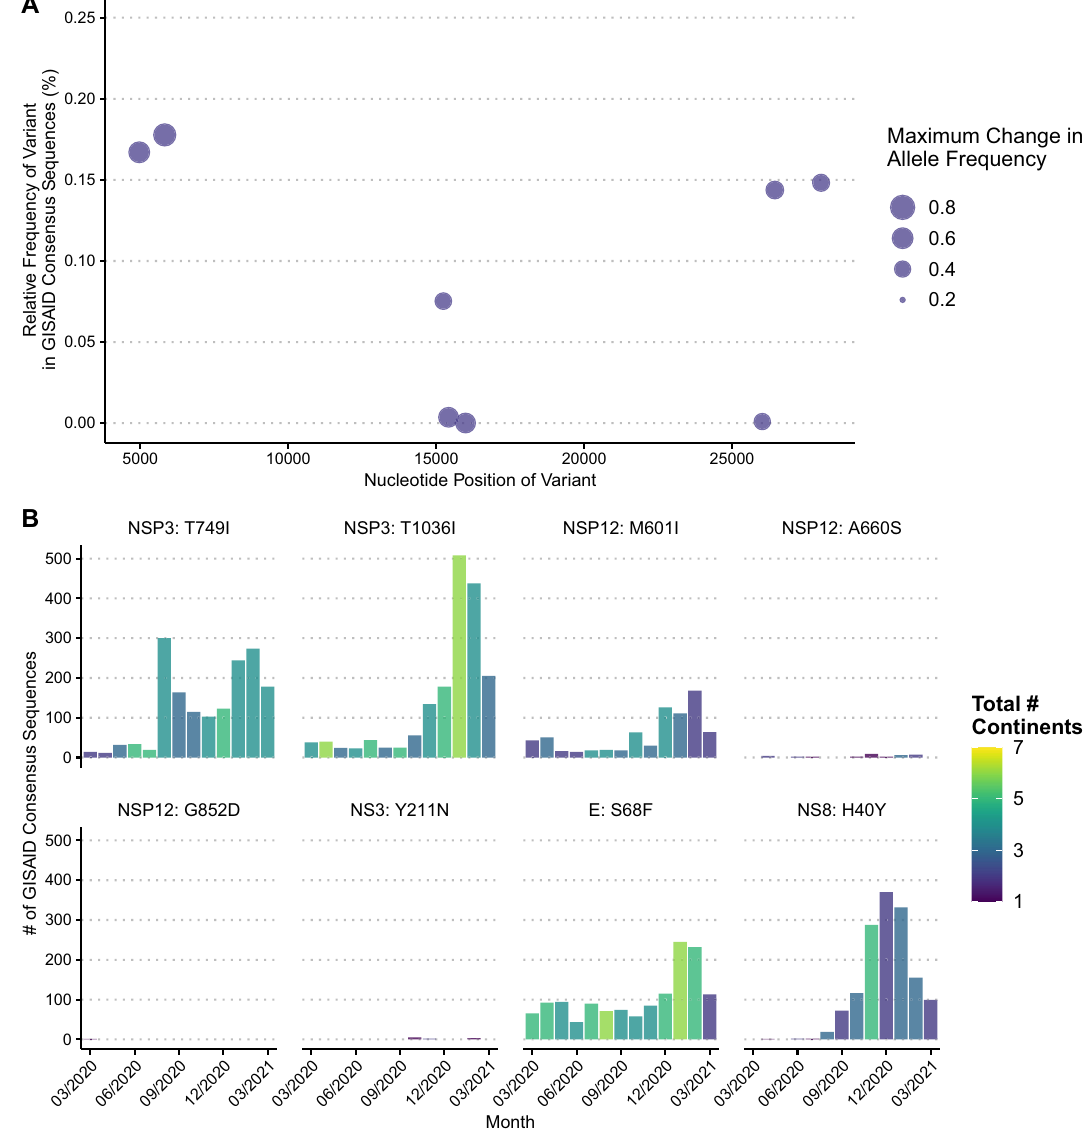
Figure 3. Variants that exhibit ≥ 40% maximum change in allele frequency in the individuals profiled here in summer 2020 show limited ability to predict future GISAID consensus sequences as of April 2021. ( A ) Relative frequencies of the derived allele found in GISAID consensuses across the genome. Dots represent each unique variant with size indicating the maximum intra-host change in allele frequency found in our study. ( B ) Number of GISAID consensuses with the derived allele for each variant. Height of vertical bars represents the total number of consensuses with the derived allele collected for each month from March 2020 to March 2021 and bar color represents the number of continents of origin for these